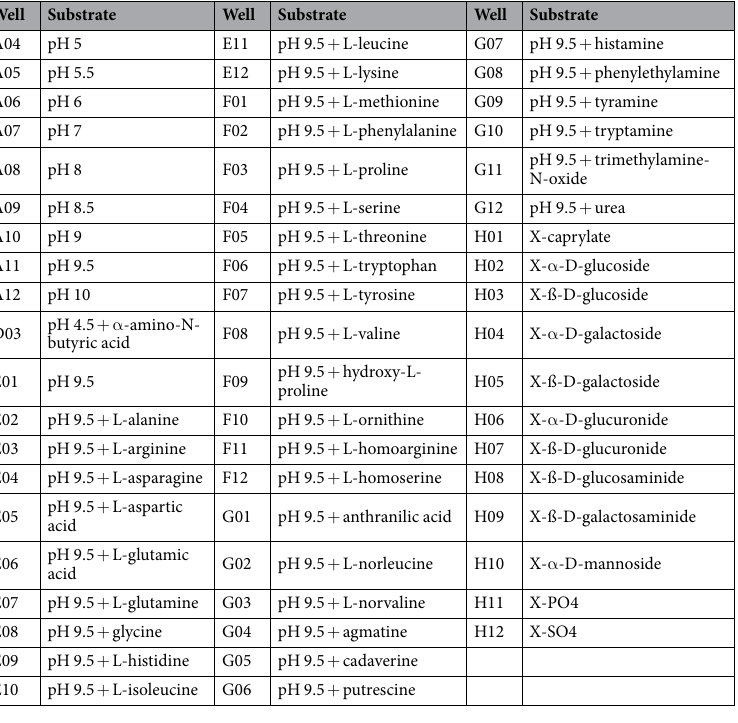
Table 6. Substrates in the PM 10 Biolog MicroPlate metabolized by the larval gut bacterium Enterococcus mundtii from the diamondback moth a . a Content listed in the columns “Well” and “Substrate” refer to the layout of the Biolog PM Microplate; the numbers in the Well column indicate the substrates tested in the Biolog PM